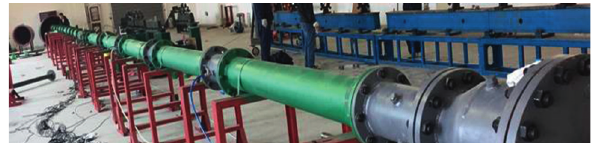
Figure 5: The flame propagation process of gas explosion before and after 500 ∗ 500 ∗ 200 cavity structure. (a) 0.089 (s). (b) 0.099 (s). (c) 0.105 (s). (d) 0.114 (s). (e)